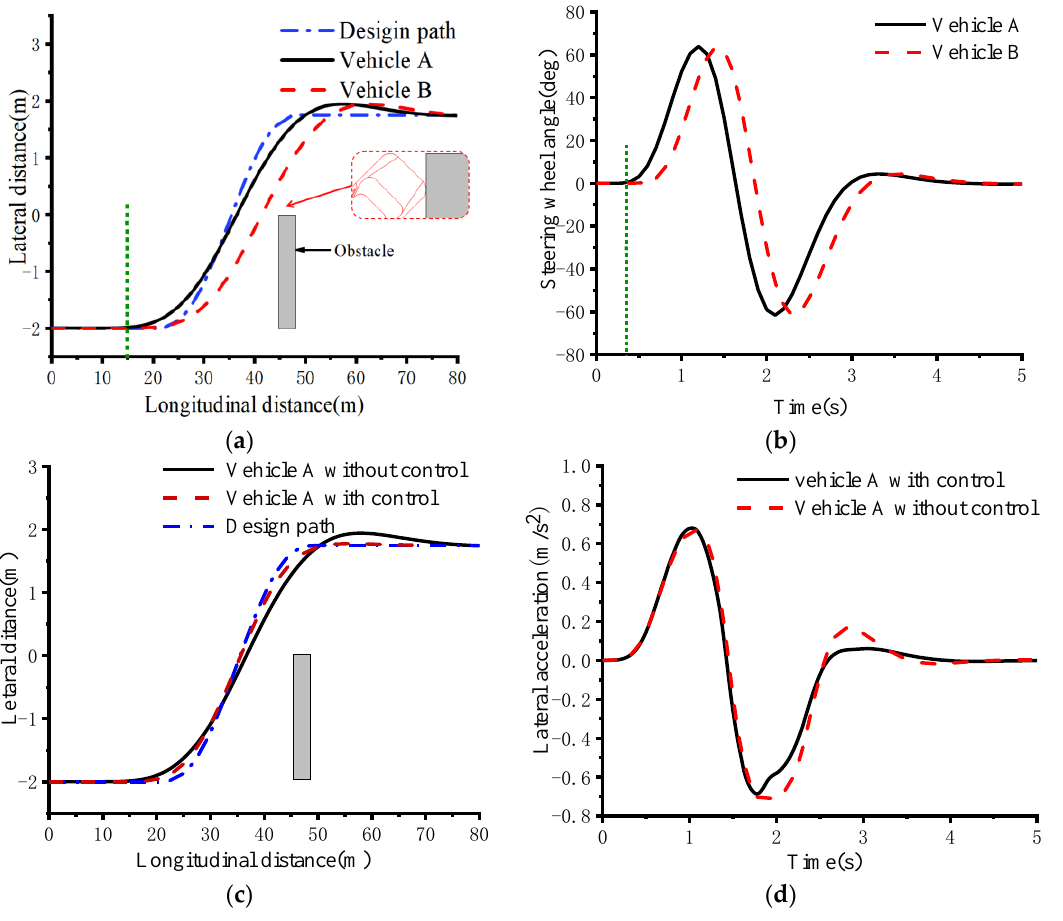
Figure 9. Simulation of lateral collision avoidance: ( a ) Lane-changing track; ( b ) Steering wheel angle; ( c ) Lane-changing track; ( d ) Lateral acceleration.